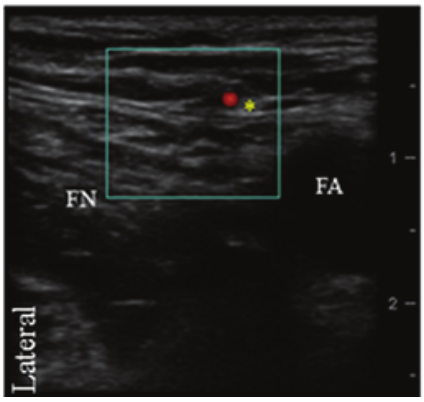
Figure 4: Transverse ultrasound image of the femoral nerve (FN) and femoral artery (FA). The anterior femoral cutaneous nerve of the thigh with its accompanying artery is also shown